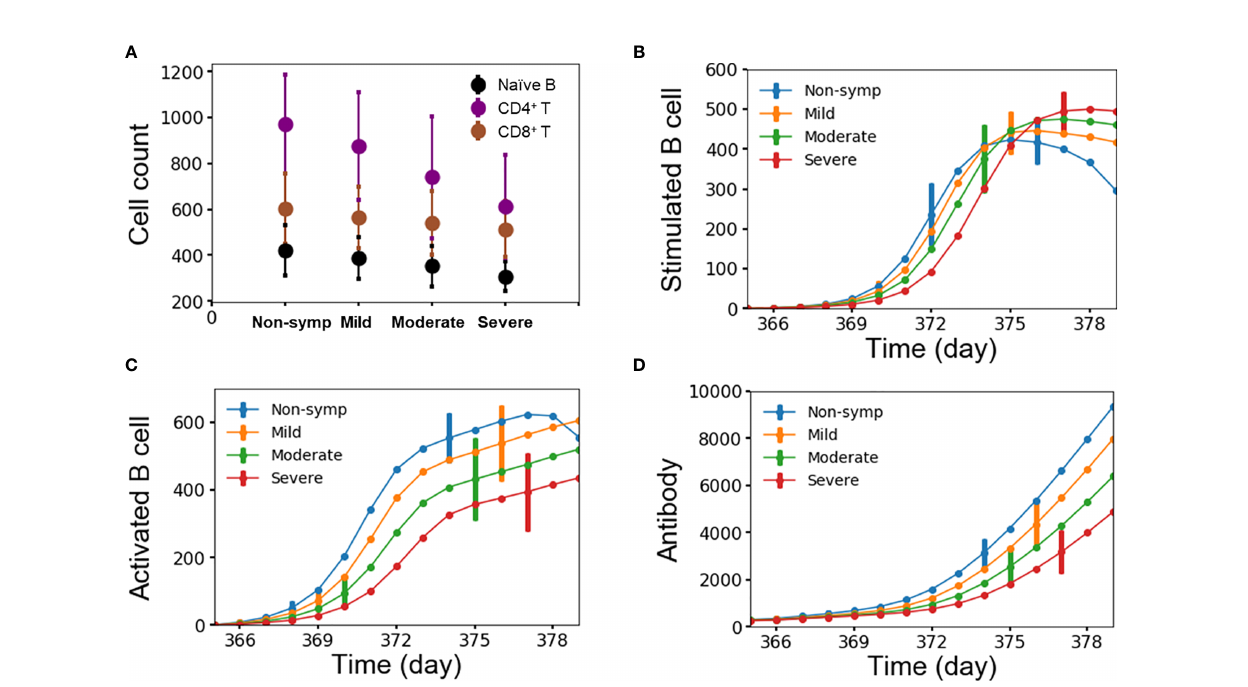
FIGURE 7 | (A) Average number of lymphocytes for each group of disease severity; (B – D) stimulated/activated B cells and antibody as a function of time for each group of disease severity from 10,000 independent simulations, error bars are shown as the standard